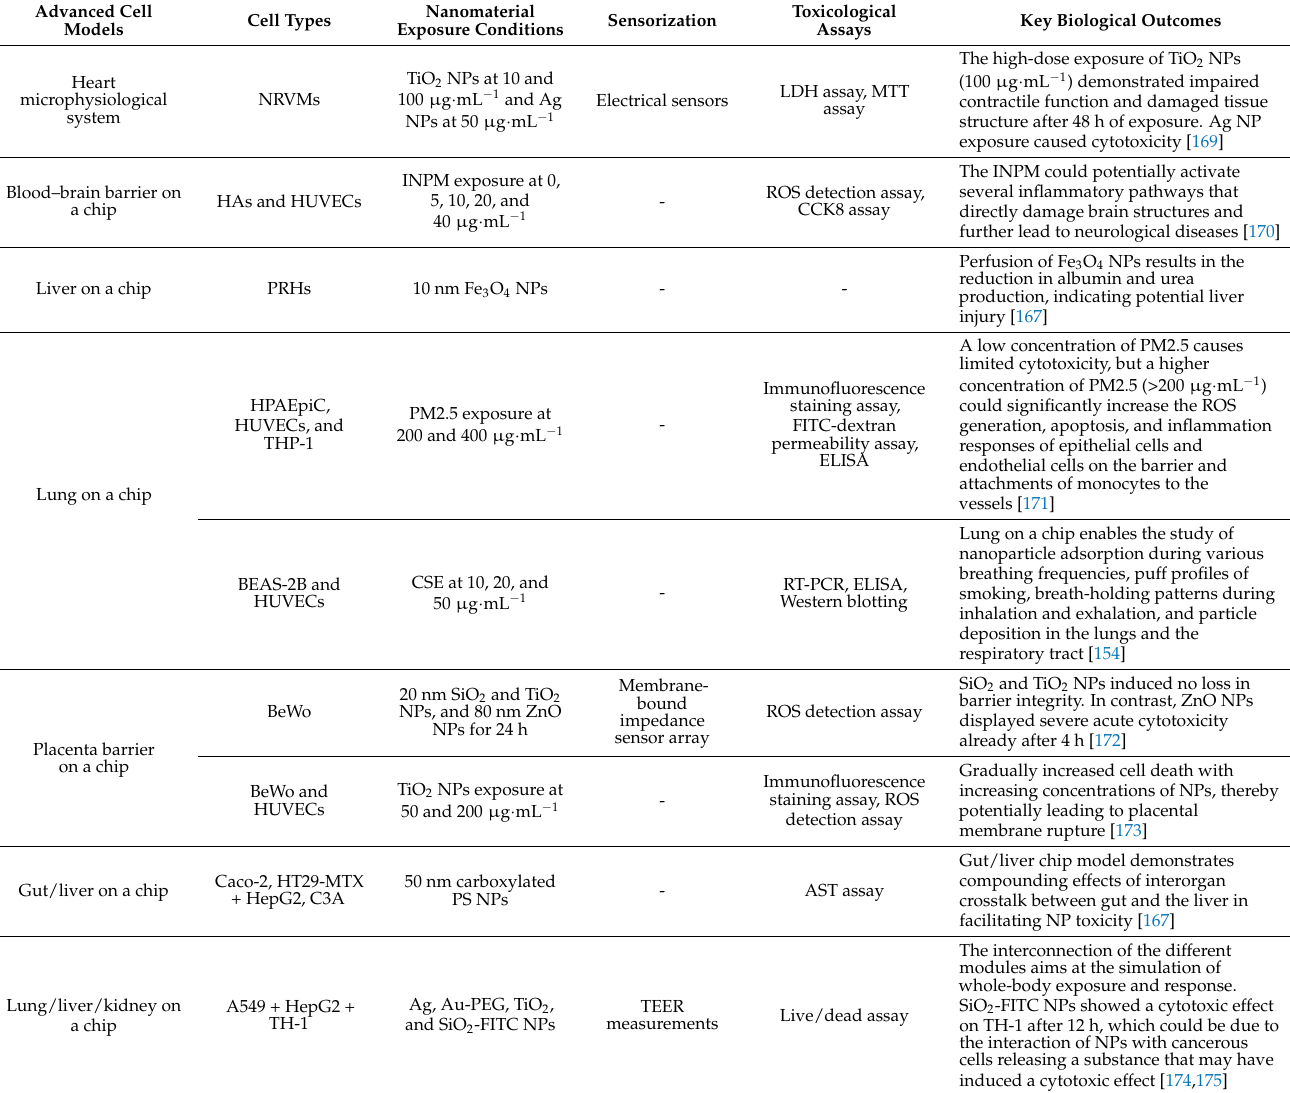
Table 4. Single- and multiple-organ-on-chip models employed in nanomaterial safety